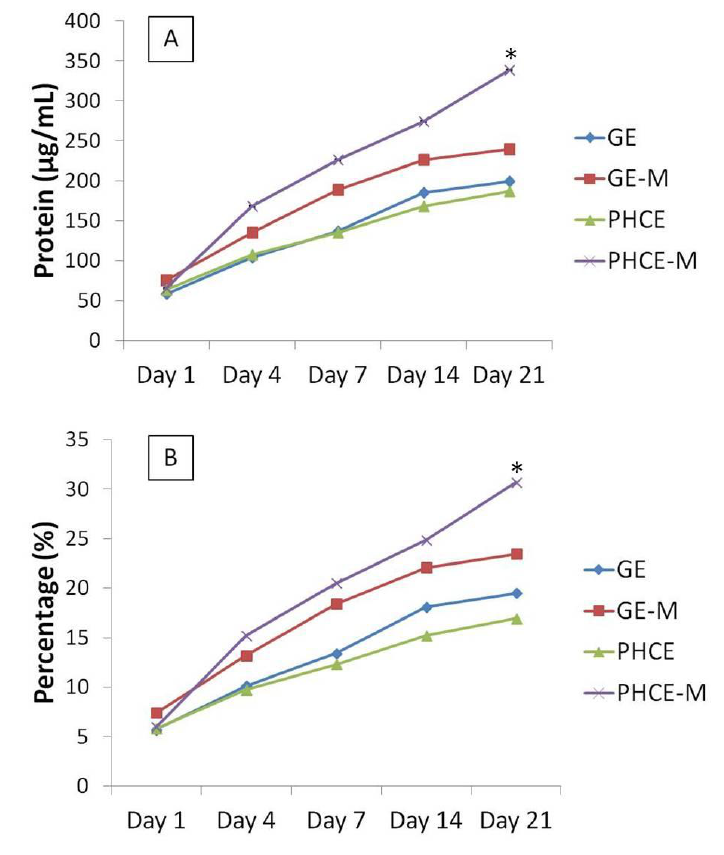
Figure 6. Cumulative protein release measured as ( A ) concentration and ( B ) percent of total protein from scaffolds over 21 days. PHCE-M sponges released the most protein from day 14 to 21. The continuous release of more protein by PHCE-M scaffolds resulted in a significantly higher percentage of total released contents